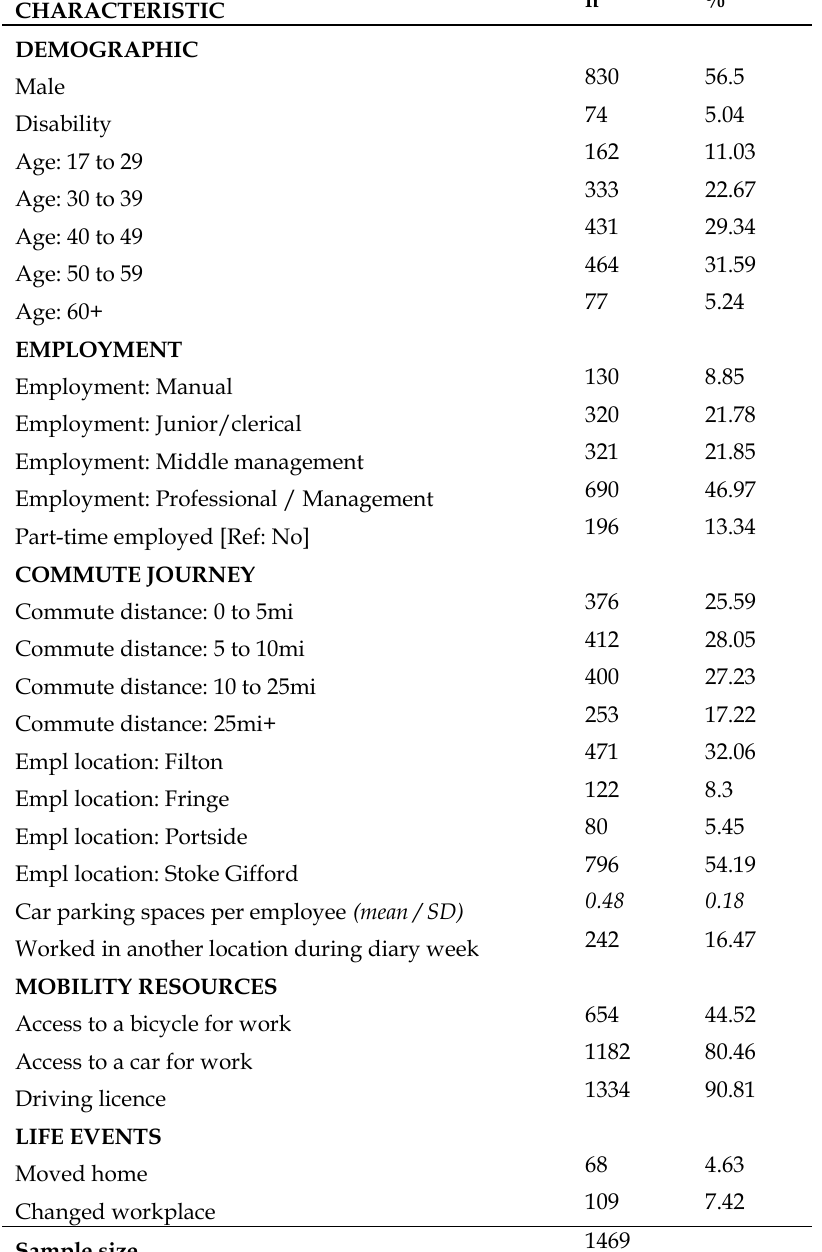
Table 3. Characteristics of wave 1 analysis